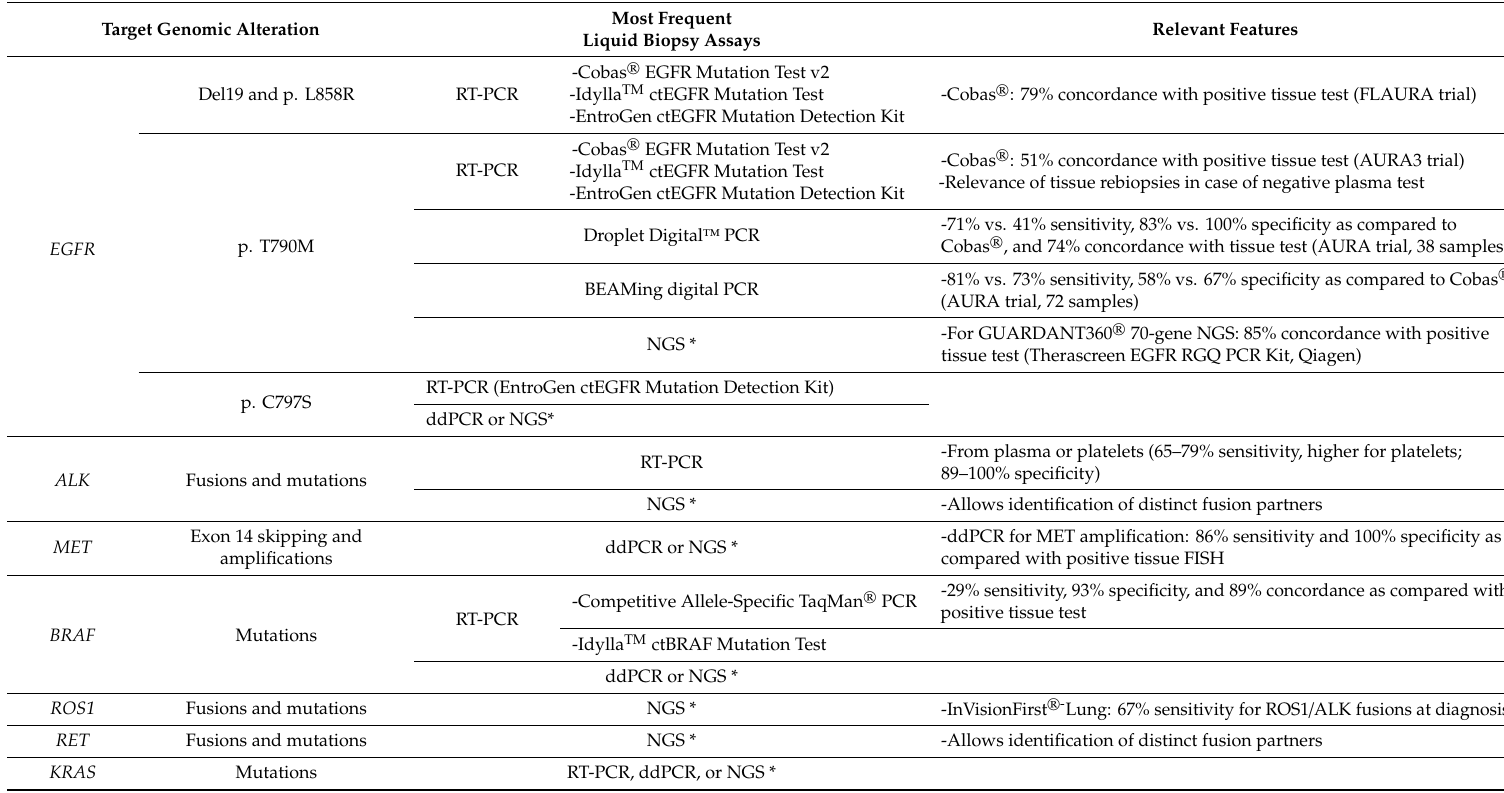
Table 2. Main target genes and mutations in non-small cell lung cancer (NSCLC) and summary of most frequently used liquid biopsy assays used for their assessment. Abbreviations: ddPCR: digital droplet PCR; NGS: next-generation sequencing; RT-PCR: real-time PCR; * e.g., Oncomine ™ Lung cfDNA Assay, FoundationOne ® Liquid CDx, GUARDANT360 ® , InVisionFirst ®